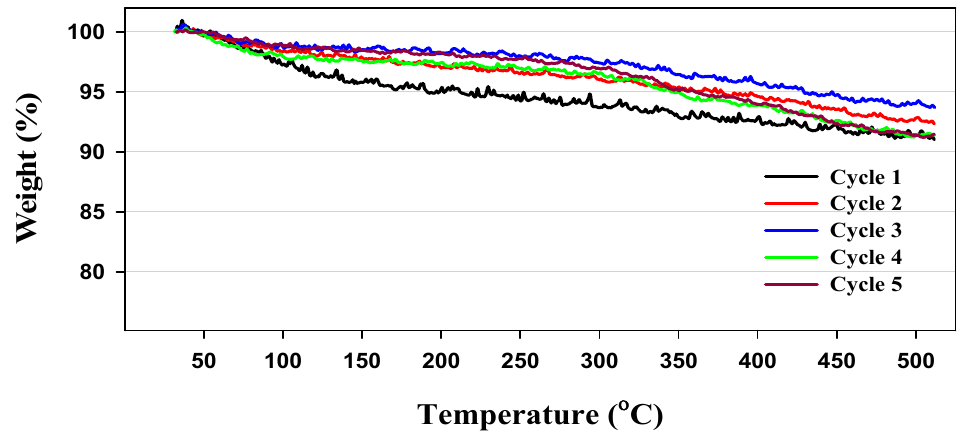
Figure 4. Thermogravimetric analysis (TGA) of recovered OSU-6.